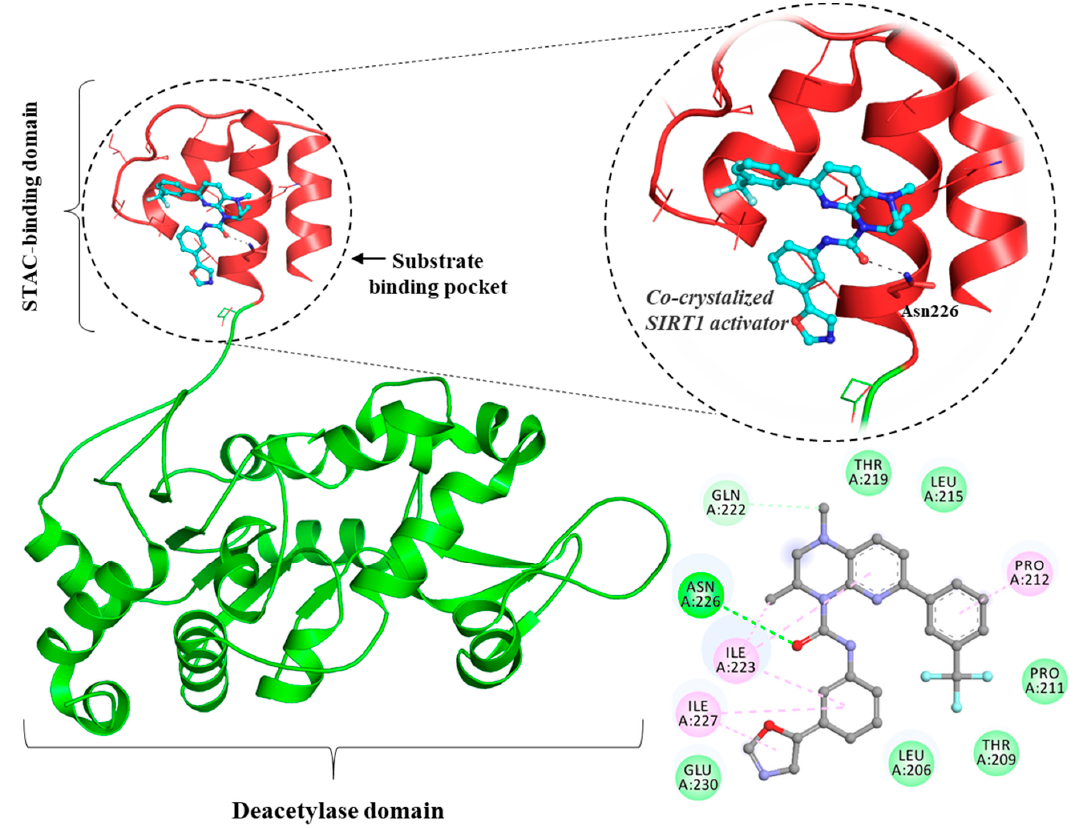
Figure 3. Structural representation of SIRT1–activator complex (PDB ID: 4ZZJ, Ref. 106). Right lower panel showing 2D representation of activator (3S)-1,3-dimethyl-N-[3-(1,3-oxazol-5-yl)phenyl]-6-[3-(trifluoromethyl) phenyl]-2,3-dihydropyrido [2,3-b]pyrazine-4(1H)-carboxamide and its interactions to SIRT1 binding-pocket residues. (Dark green shows conventional hydrogen bonds, and other residues participate in different significant interactions.)